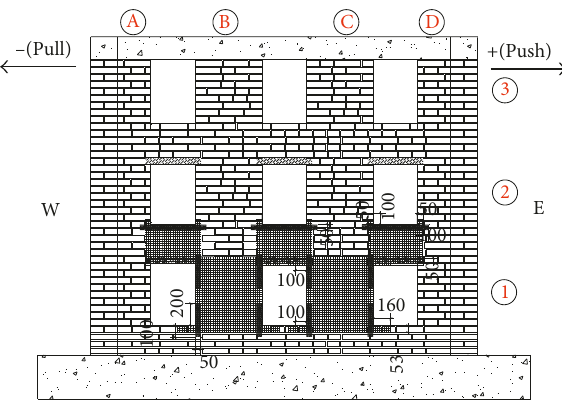
Figure 7: Repair scheme of the damaged URM